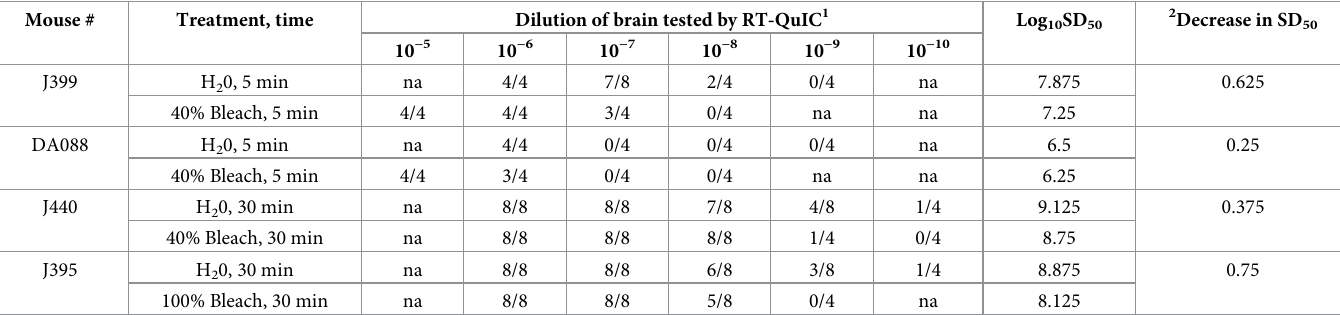
Table 4. Bleach treatment of CWD-infected transgenic mouse